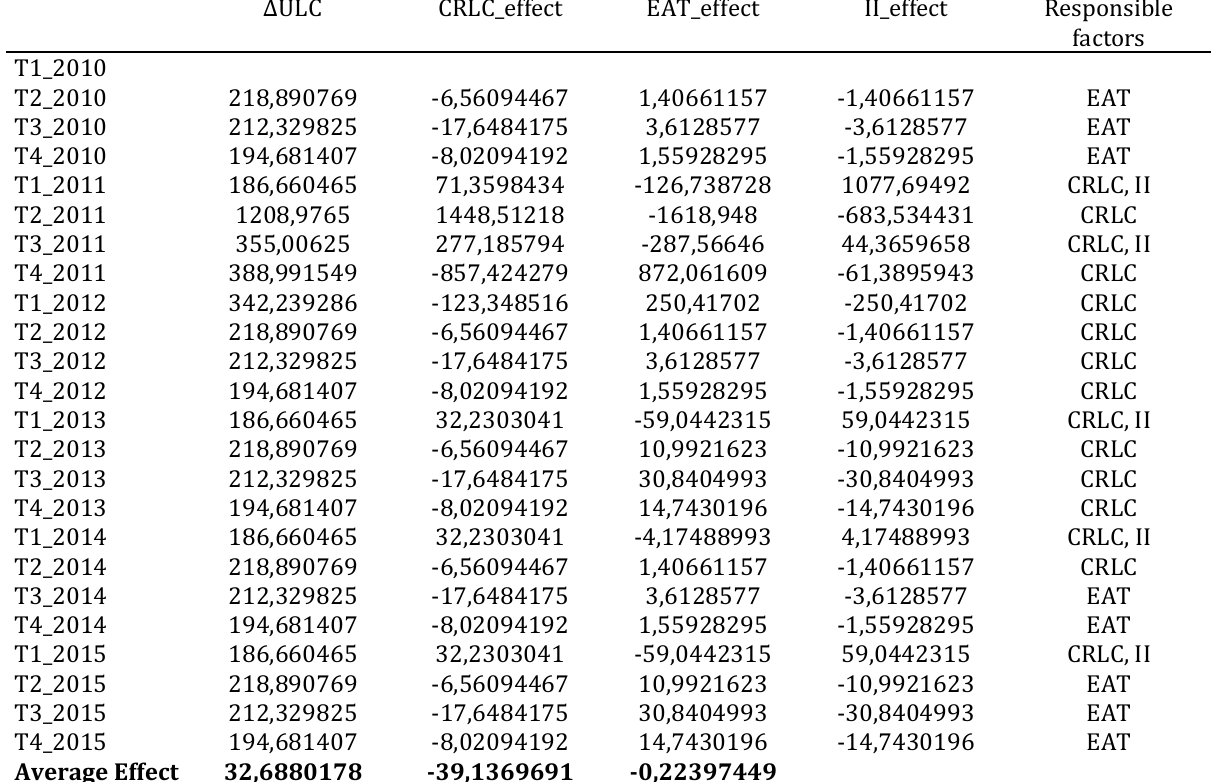
Note : Responsible factors are in the same direction as ULC